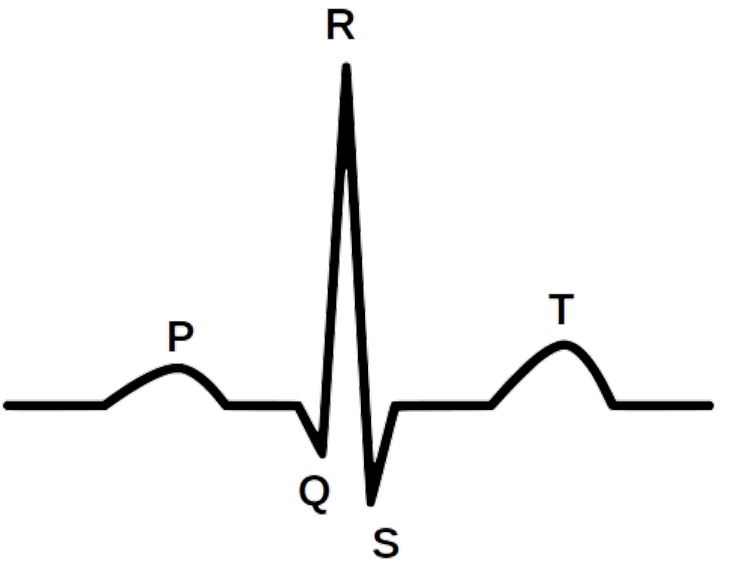
Figure 1. The illustrative waveform of the ECG